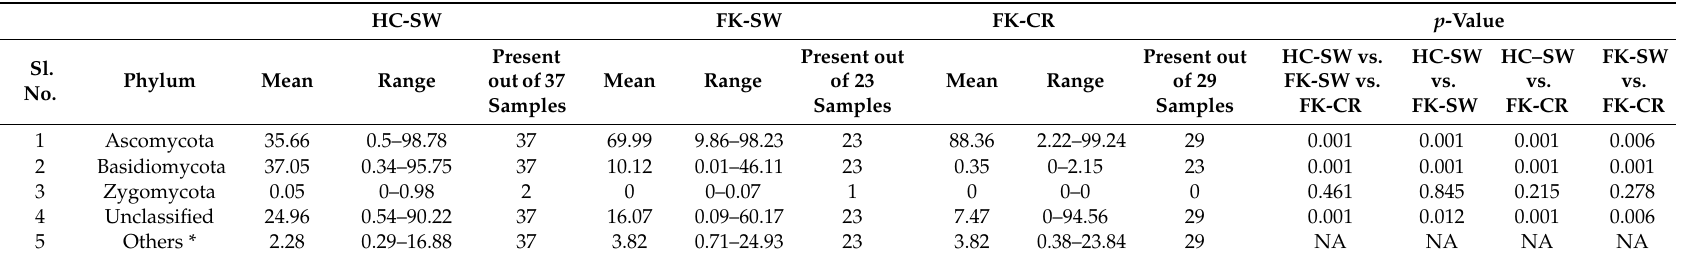
* Includes singletons and sparse operational taxonomic units (OTUs) (with < 0.001% of total high quality